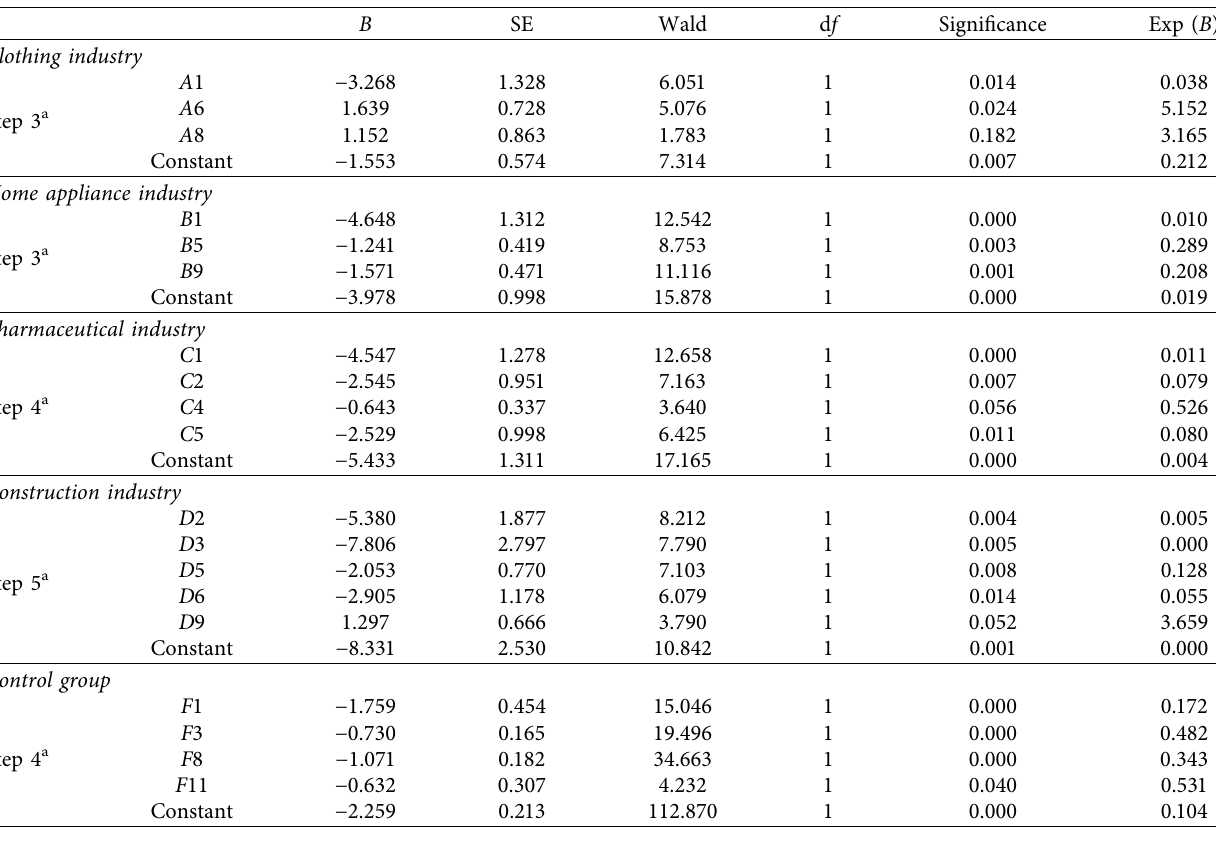
Table 13: Variables in the